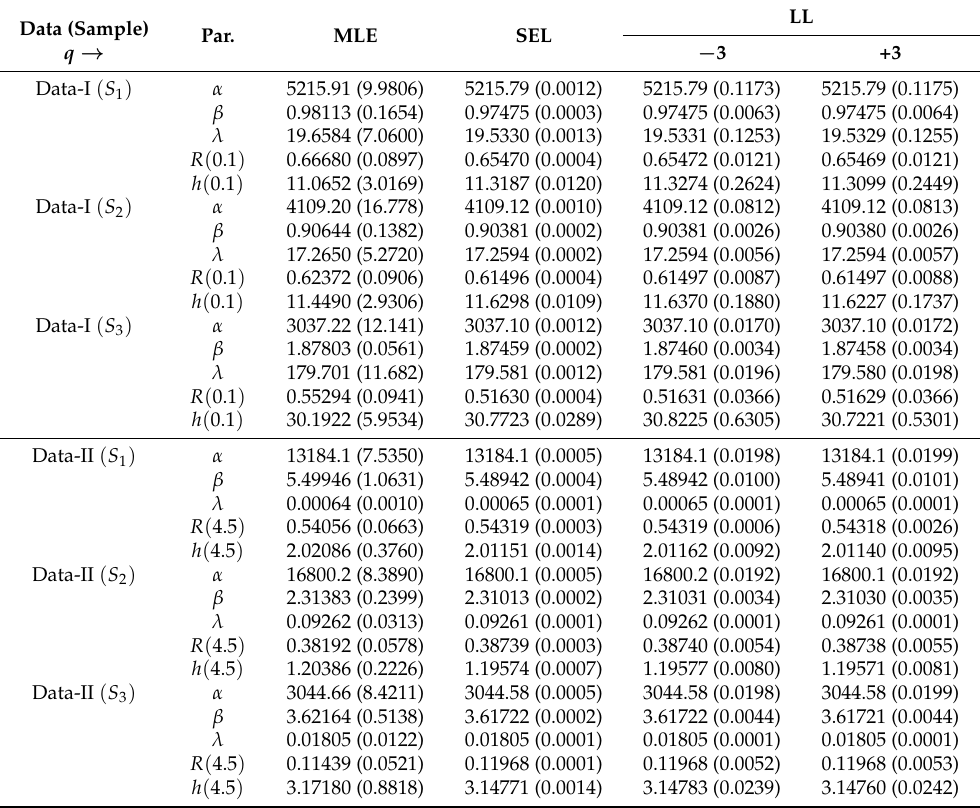
Table 5. Bayesian and non-Bayesian point estimates with their